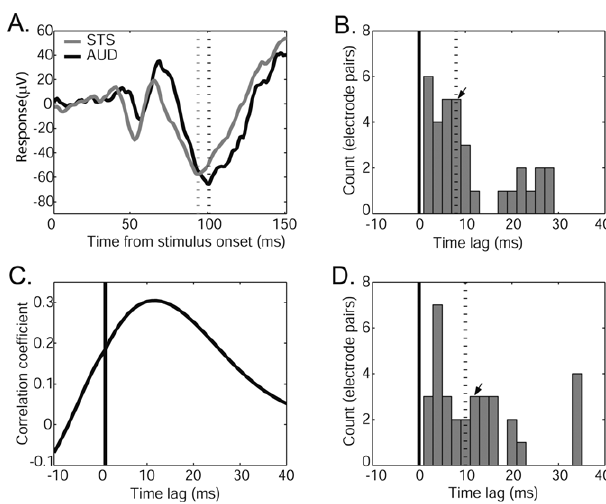
Figure 8. Comparison of response latencies to faces in auditory cor- tex and upper-bank STS. (A) Example responses from an adjacent pair of electrodes, one in auditory cortex (black) and one in STS (gray). Responses conventions as in Figure 3 . Dashed lines appear at the “N100” peaks. Note the similarity of the response magnitude for the two simultaneously-recorded sites. (B) Distribution of peak latency differences between adjacent pairs of AUD and STS electrodes. The dashed line indicates the median peak latency difference, and the arrow indicates the location in the distribution of the example pair shown in A. (C) Cross-correlation between the example responses shown in A. The peak correlation coeffi cient indicates the offset at which the STS and AUD responses are most similar (i.e., the time point of maximal correlation). (D) Distribution of peak correlation time points between AUD and STS electrode pairs. The dashed line indicates the median and the arrow indicates the location of the maximal correlation for the example pair. Both “N100” peak latency (B) and maximal-correlation (D) analyses reveal a consistent time lag between STS and AUD responses, with no examples of an auditory cortex response preceding that of its paired STS